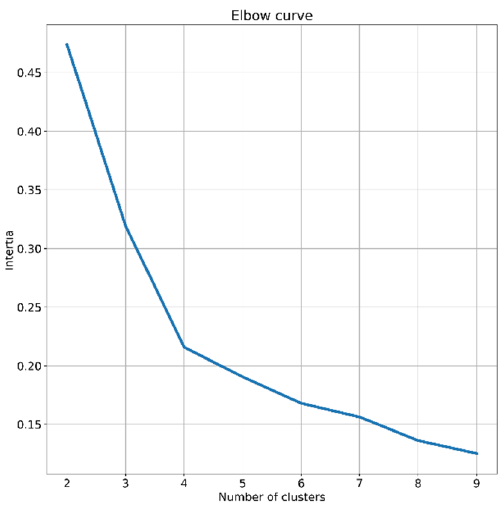
Figure 1. A schematic of elbow analysis operated to decide the number of clusters.